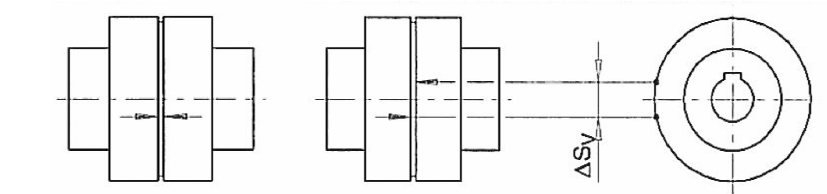
Figure 16 – Testing the rubber elastic elements of the couplings Flender N-480 and A-EUPEX RUPEX RWN 710 Рисунок 16 – Тестирование резиновых эластичных муфт типа N-480 и A-EUPEX RUPEX RWN 710 Слика 16 – Провера исправности гумених еластичних елемената спојница